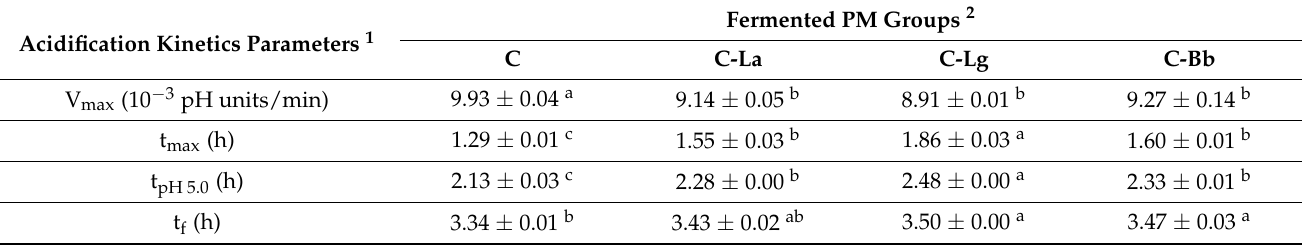
Figure 2. Changes in pH of fermented PMs during fermentation time. C = PM fermented with Strep- tococcus thermophilus and Lactobacillus bulgaricus ; C-La = PM fermented with S. thermophilus , L. bul- garicus , and Lactobacillus acidophilus ; C-Lg = PM fermented with S. thermophilus , L. bulgaricus , and Lactobacillus gasseri ; C-Bb = PM fermented with S. thermophilus , L. bulgaricus , and Bifidobacterium bi- fidum . Results are expressed as mean ± standard error ( n = 3). bifidum . Results are expressed as mean ± standard error ( n = 3). Table 3. Acidification kinetic parameters of fermented PM groups. Table 3. Acidification kinetic parameters of fermented PM